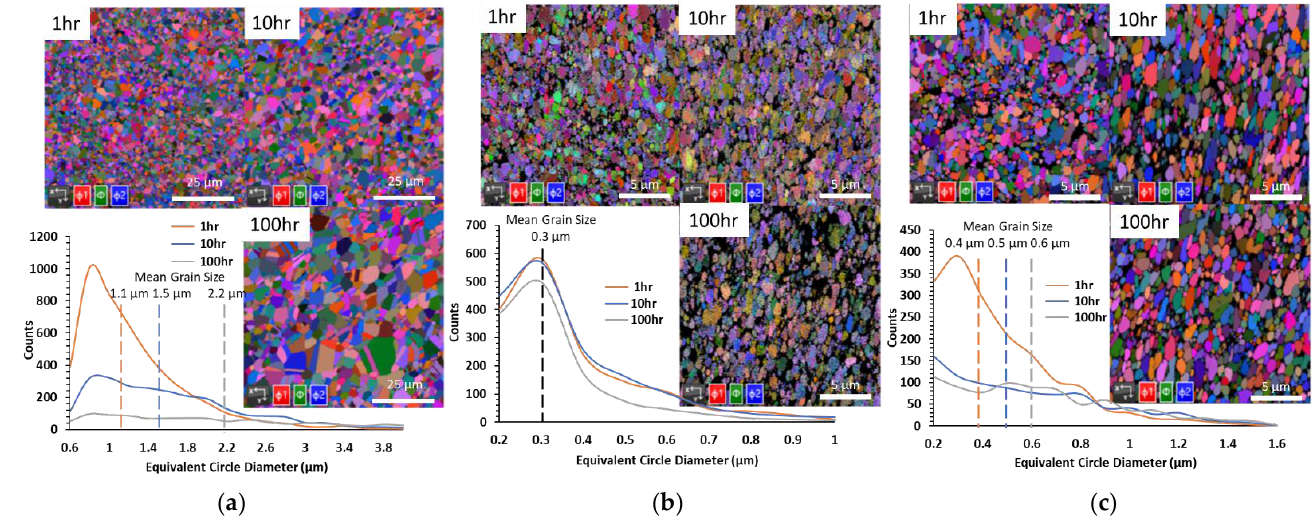
Figure 12. Grain size distribution and orientation for the composite layer TBC ( a ) bond coat, ( b ) YSZ, ( c ) GZ + YSZ layers.